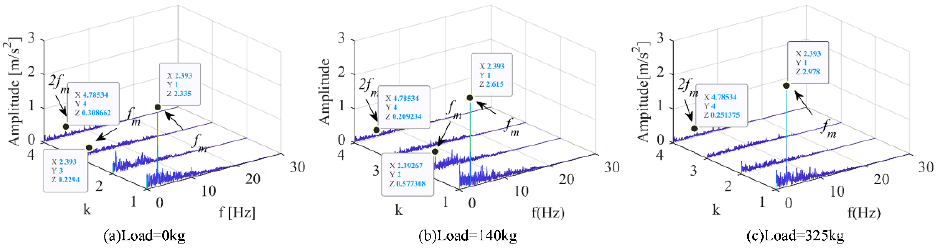
Figure 10. Vibration demodulation diagram of down main machine under different loads of elevator. ( a ) Motor running under no-load condition. ( b ) Motor running under 140kg load condition. ( c ) Motor running under 325kg load condition.